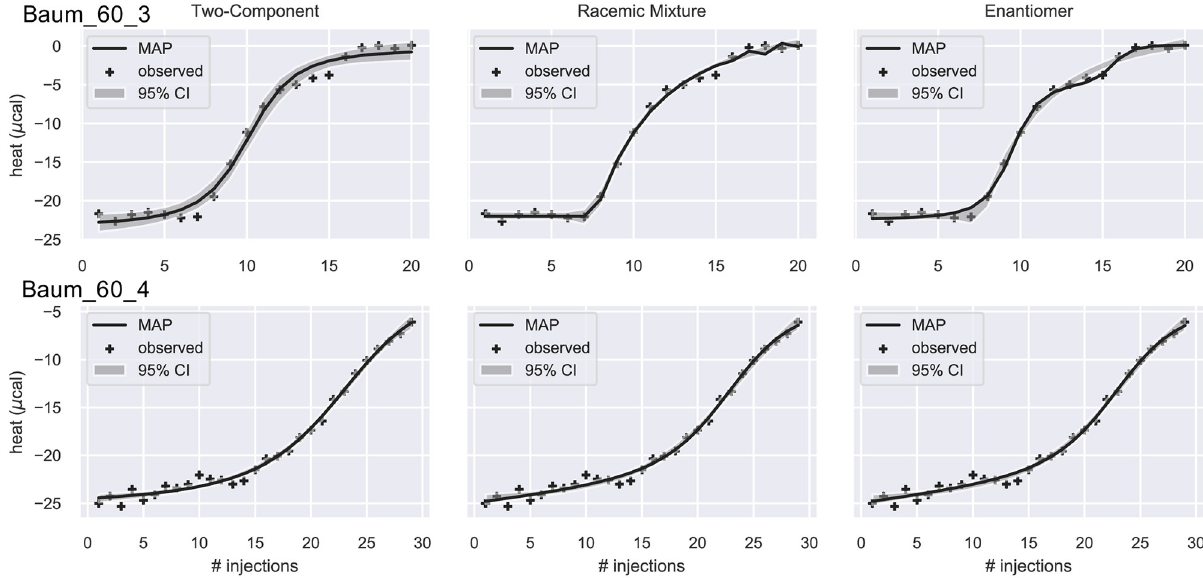
Fig 8. Integrated ITC heat data and their fit. The data were fitted by the 2C (left), RM (middle), and EM (right) models. The solid line is the theoretical heat q � ð θ Þ , where θ MAP is the Maximum a Posteriori estimate of the parameters. The grey band is the 95% confidence interval. Crosses MAP n are the observed heat. For these two datasets, the estimated Bayes factors (Table 3) is inconclusive in selecting which model is the best.